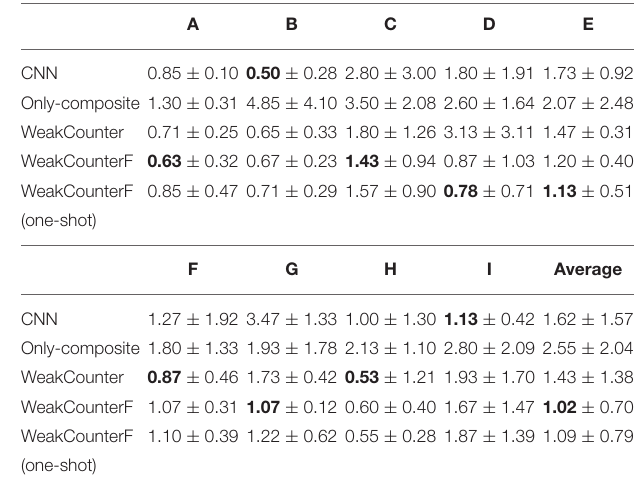
TABLE 4 | MAE of each subject for each method.